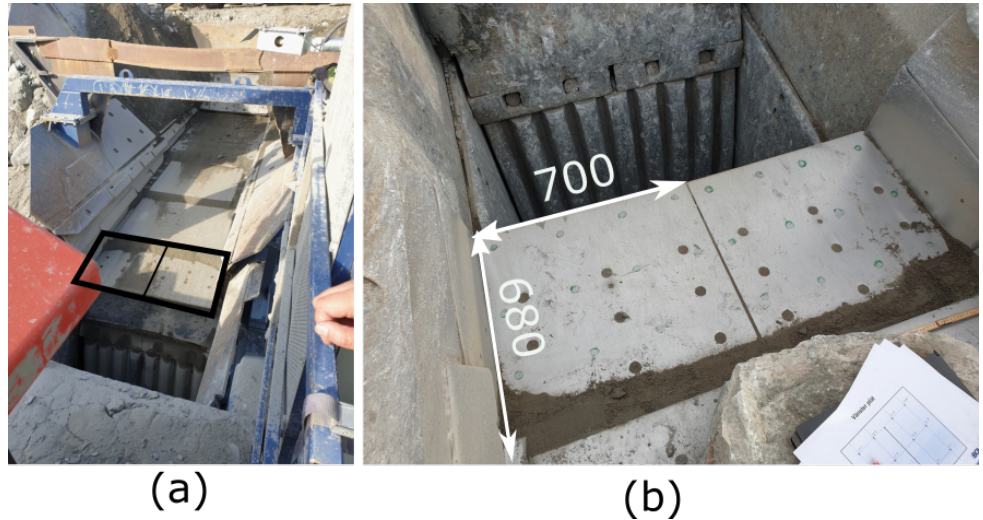
Figure 3. The Hardox 450 wear plates location on the feeder is shown ( a ). A close up look on the plates ( b ) are seen from behind and the dimensions for one plate are